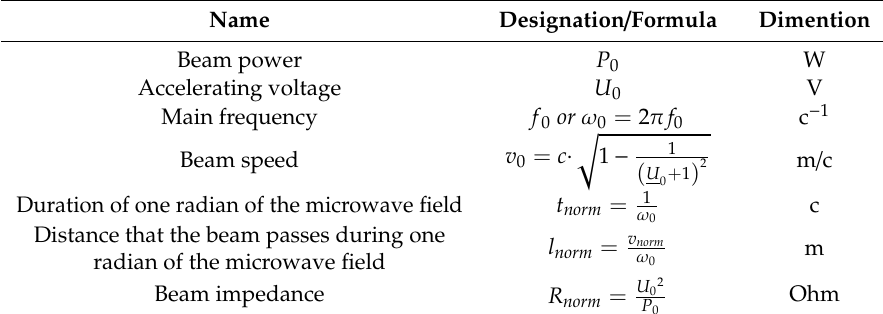
Table 4. Values for functional